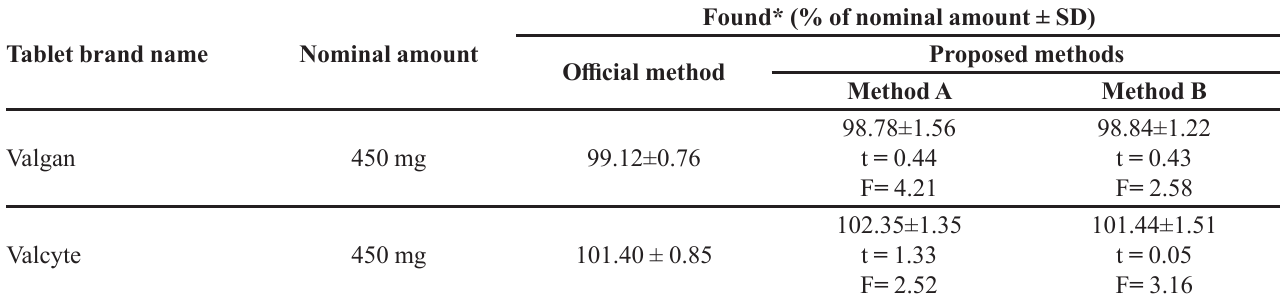
*Mean value of five determinations. (Tabulated t-value at the 95% confidence level and for four degrees of freedom is 2.78). (Tabulated F-value at the 95% confidence level and for four degrees of freedom is